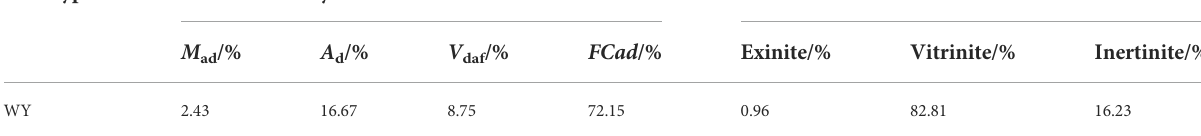
TABLE 1 Industrial analysis and microstructure of the coal sample.